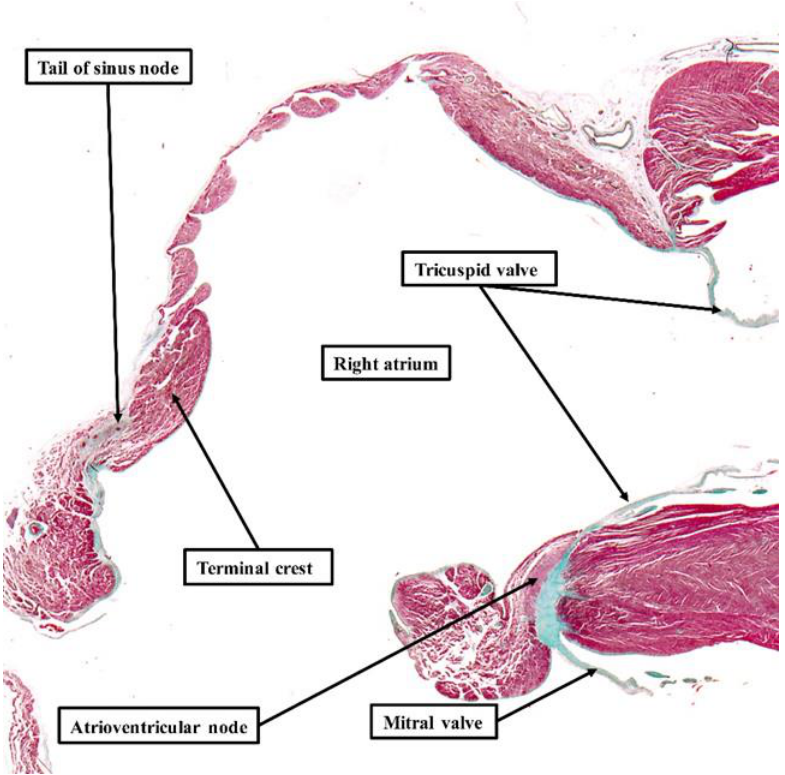
Figure 6. Absence of specialized tracts within atrial walls: The section is taken from a human of 35 weeks. It shows the entirety of the walls of the right atrium, with the section again stained using the trichrome technique. Even at the low power of magnification used to show the features of the right atrium, it is possible to recognize the tail of the sinus node and the atrioventricular node. The atrial walls, however, do not contain any insulated tracts comparable to the right bundle branch (see Figure 5). Only when assessing the entirety of the atrial myocardium in this fashion, using serial histological sections, is it justifiable to draw any conclusions regarding the presence or absence of “specialized” tracts responsible for conduction. When using the criteria established by Mönckeberg and Aschoff [3,4], which retain their validity for histological studies, examination of serial sections shows that there are no such tracts.